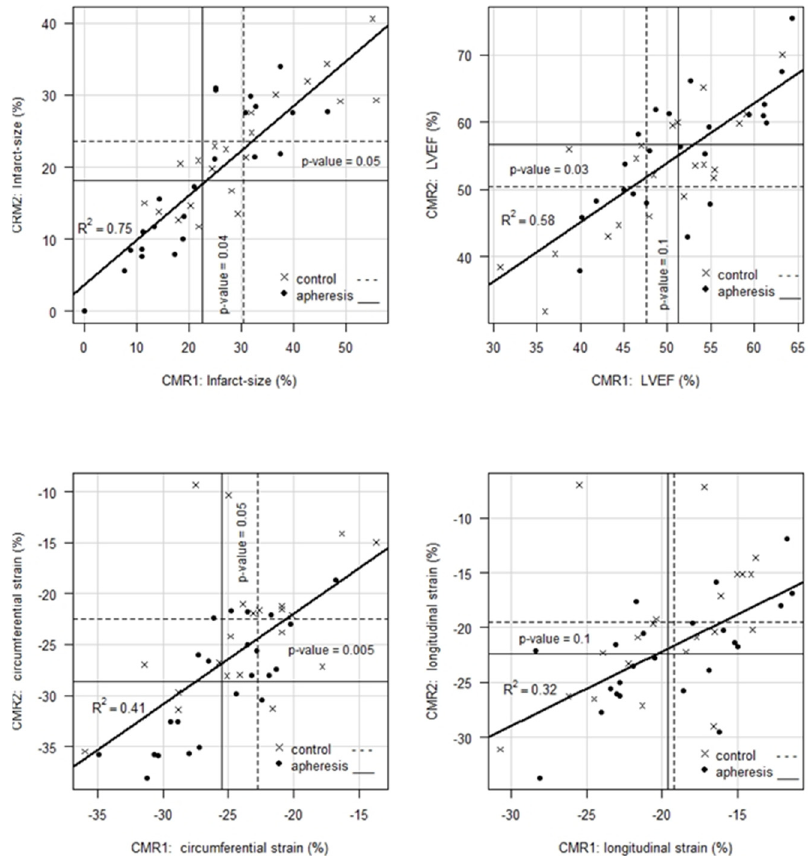
Figure 2. Correlation and temporal evolution of IS (%), LVEF (%), CS (%) and LS (%) in CMR1 and CMR2. The vertical/horizontal lines mark the mean values concerning CMR1 and CMR2 for control and apheresis group. The regression line plotted in each graph represents the evolution over time of both control and apheresis patients, as they are statistically identical in each case. All endpoints other than LS show significant improvements of the parameters in CMR2 compared to CMR1, especially in the apheresis group. Please see also Tables 1 and 2.